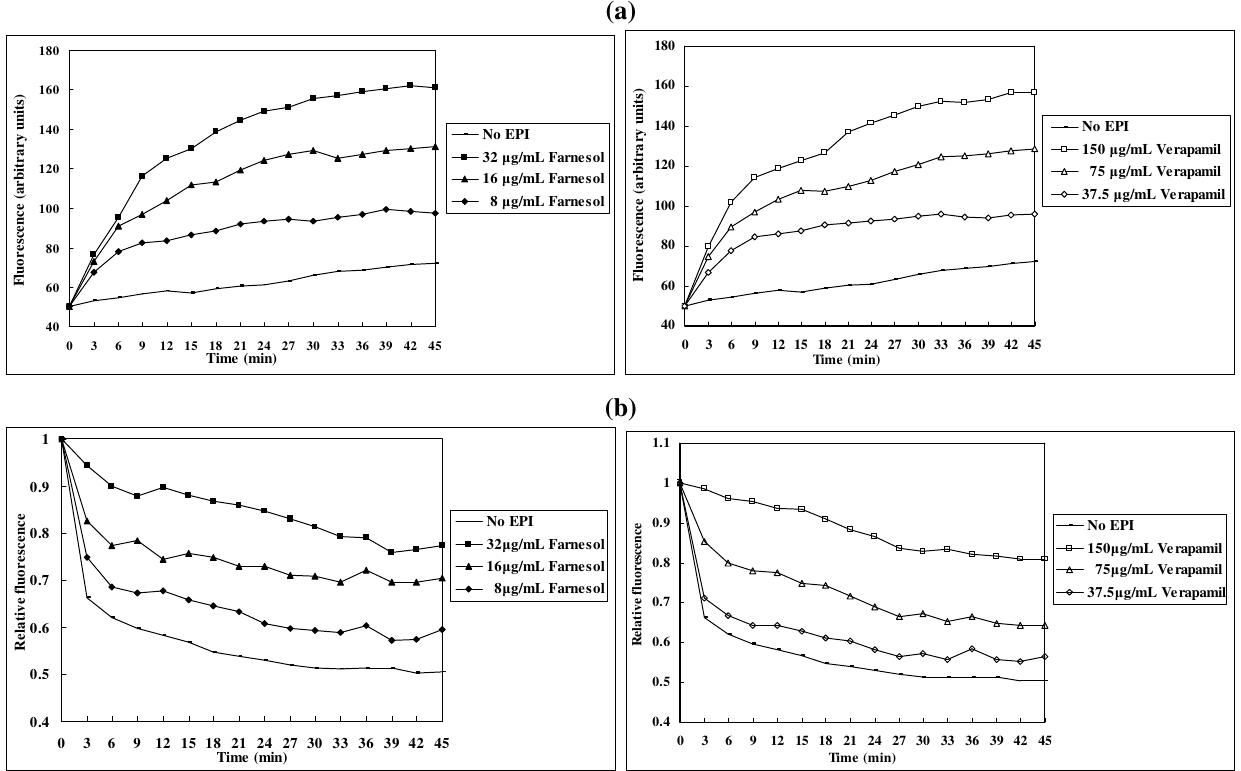
Figure 4. Effect of farnesol and verapamil on the accumulation (a) and efflux (b) of EtBr from M. smegmatis mc 2 155 cells in different